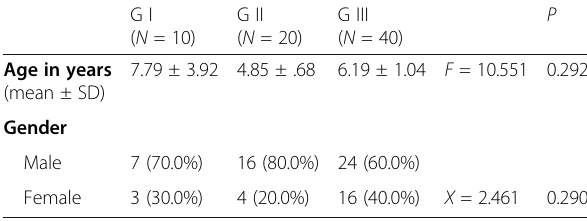
Table 1 Demographic data of the three studied groups ( n = 70)